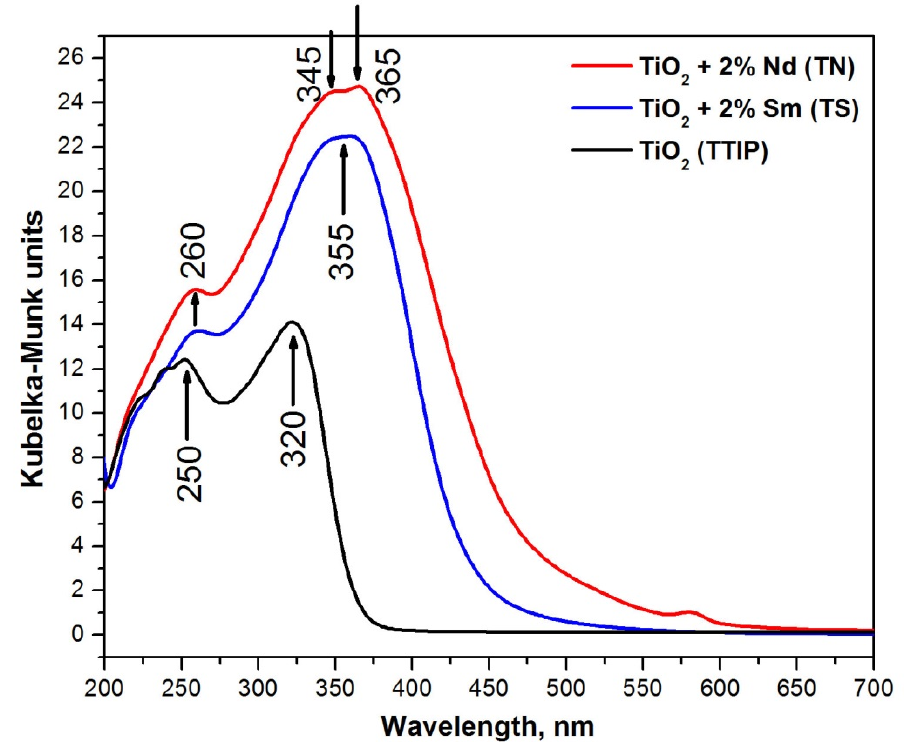
Figure 6. DR UV-Vis spectra of TN, TS, and pure Ti(IV) isopropoxide gels.